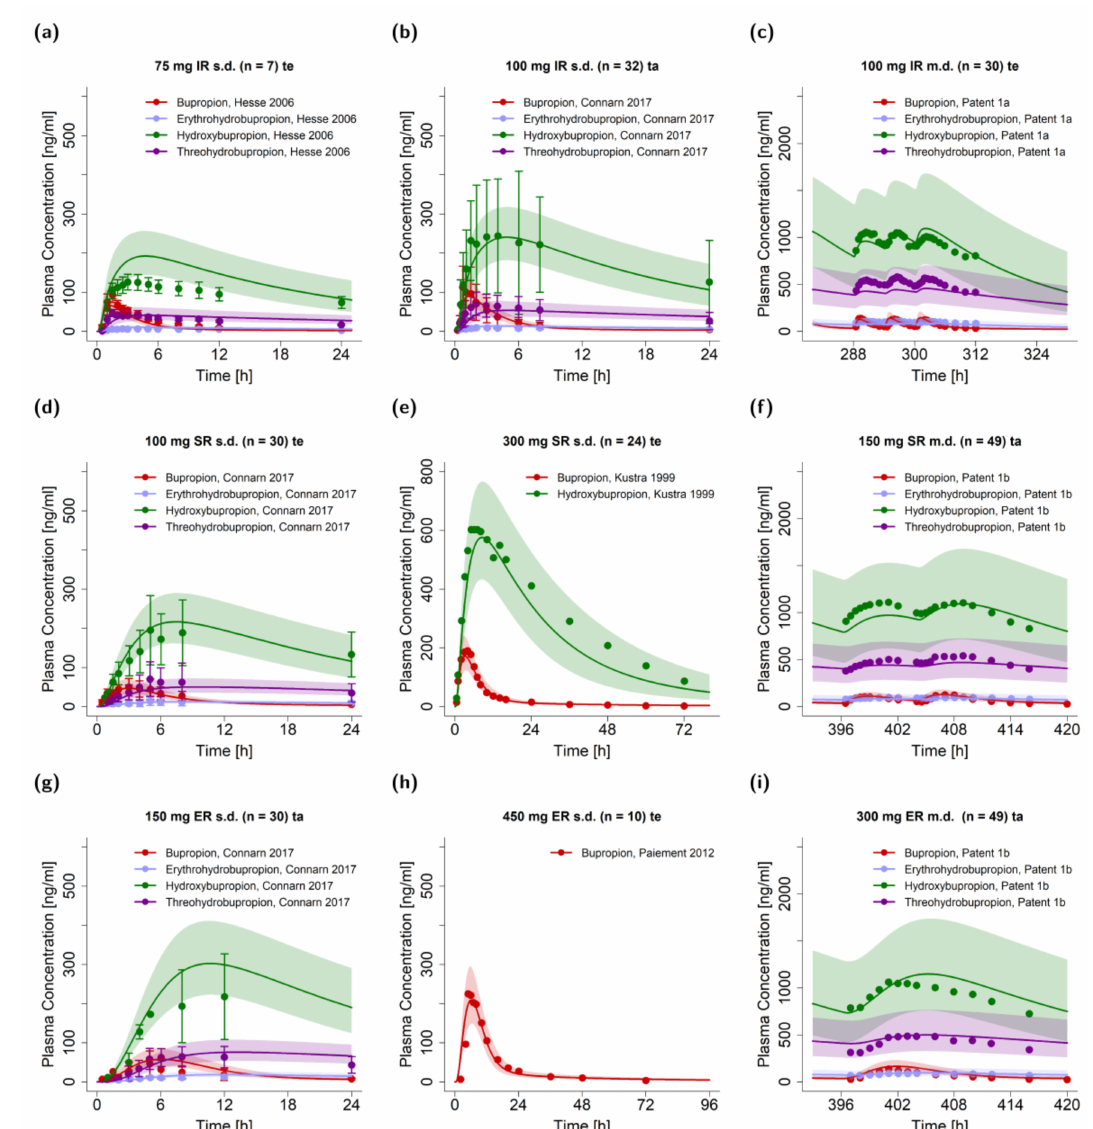
Figure 2. Predicted plasma concentration-time profiles of selected clinical studies from test and training datasets for bupropion, hydroxybupropion, erythro- and threohydrobupropion after application of single and multiple oral tablets with immediate release ( a – c ), sustained release ( d – f ) and extended release ( g – i ) kinetics compared to observed data [3,28,32,51,54]. The geometric means of the population predictions ( n = 500) are shown as solid lines and corresponding observed data as dots (arithmetic mean ± standard deviation, if available). The shaded areas indicate the geometric standard deviation. Detailed information on study protocols is provided in Table S2.1 of the Supplementary Materials. ER: extended release, IR: immediate release, m.d.: multiple dose, n: number of participants, s.d.: single dose, SR: sustained release, ta: training dataset, te: test